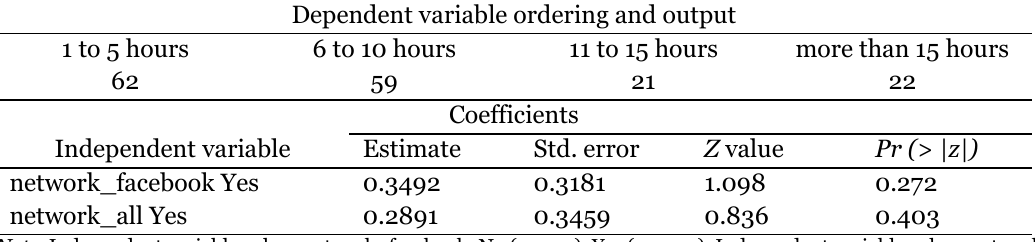
Significance of Study Time, With Social Media as Independent Variables